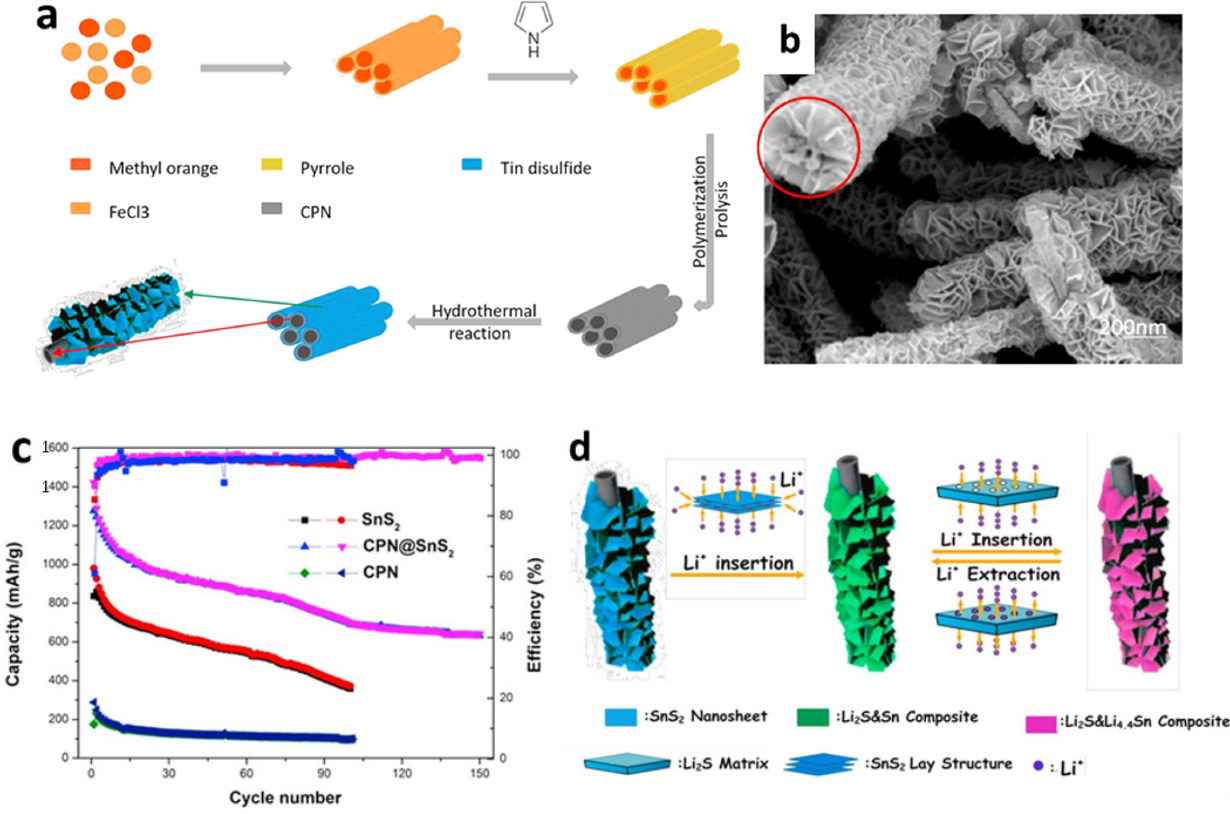
Figure 5. ( a ) Formation mechanism, ( b ) an SEM image, ( c ) cycling performance, and ( d ) a schematic illustration of the Li insertion/extraction mechanism of CPN@SnS 2 composites. Reprinted with permission from Ref. [127]. Copyright 2017 Elsevier.